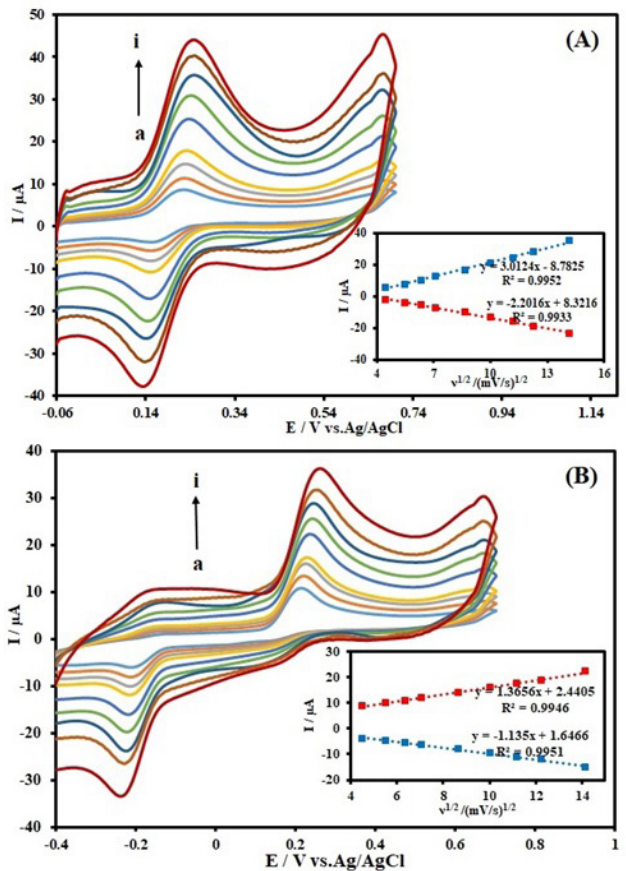
Fig. 9. Cyclic voltammograms of 500 µM DA (A) and 500 µM EP (B) at GCE/RGO/TiO various scan rates (a to i; 20-200 mV s -1 , respectively). Insets: Plot of I